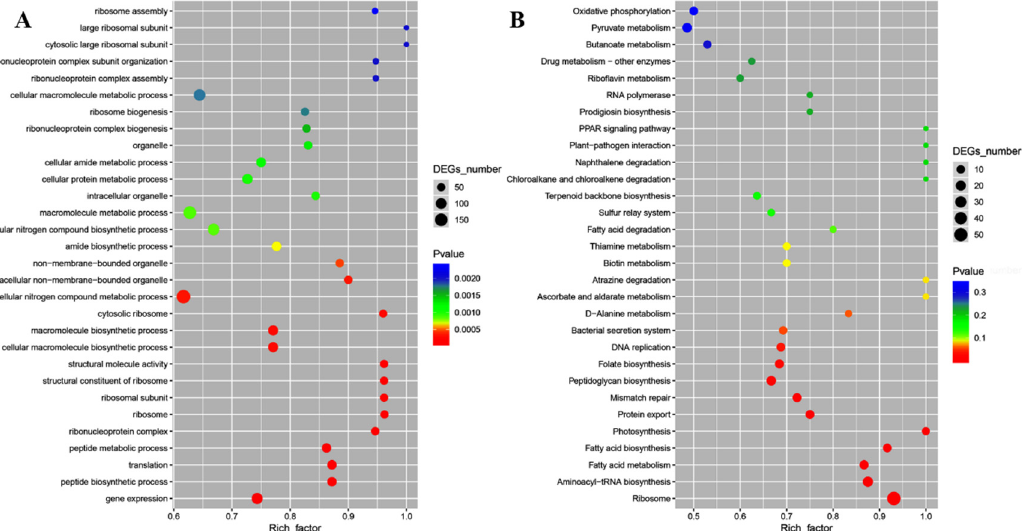
Figure 7. The GO enrichment scatter plot ( A ) and KEGG enrichment scatter plot ( B ) of differentially expressed genes treated with CFS from L. rhamnosus SCB0119 in S. aureus ATCC6538.